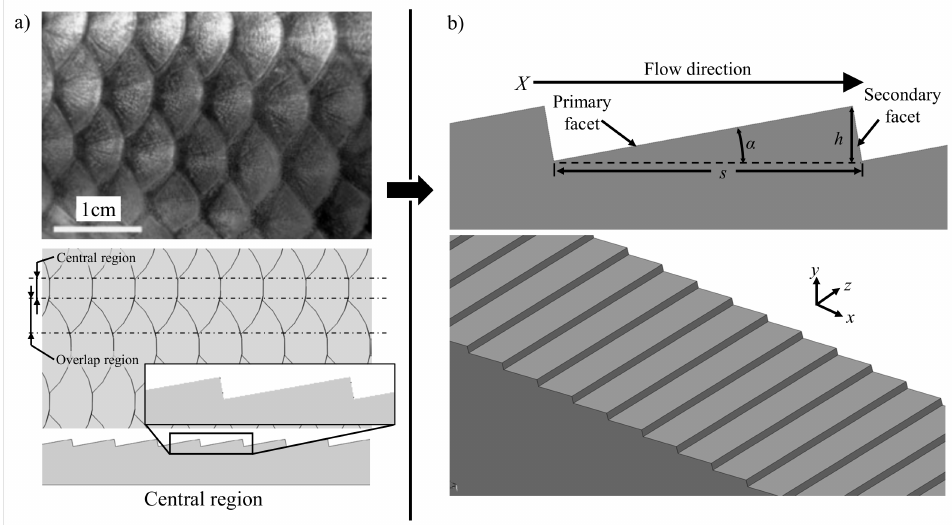
Figure 1. Overview of fish scale geometry: ( a ) topography of typical fish-scales (adapted from [16]), and ( b ) proposed design of asymmetric triangular